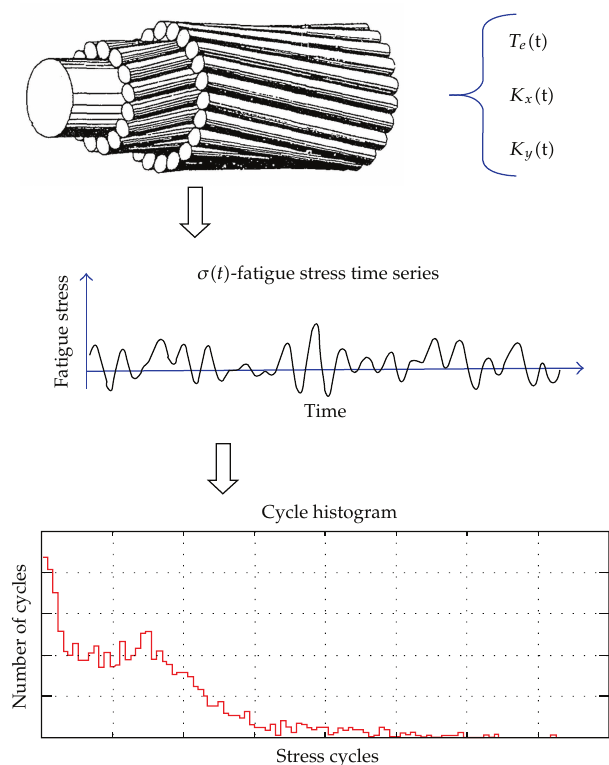
Figure 13: Short-term fatigue analysis for one hotspot/helix